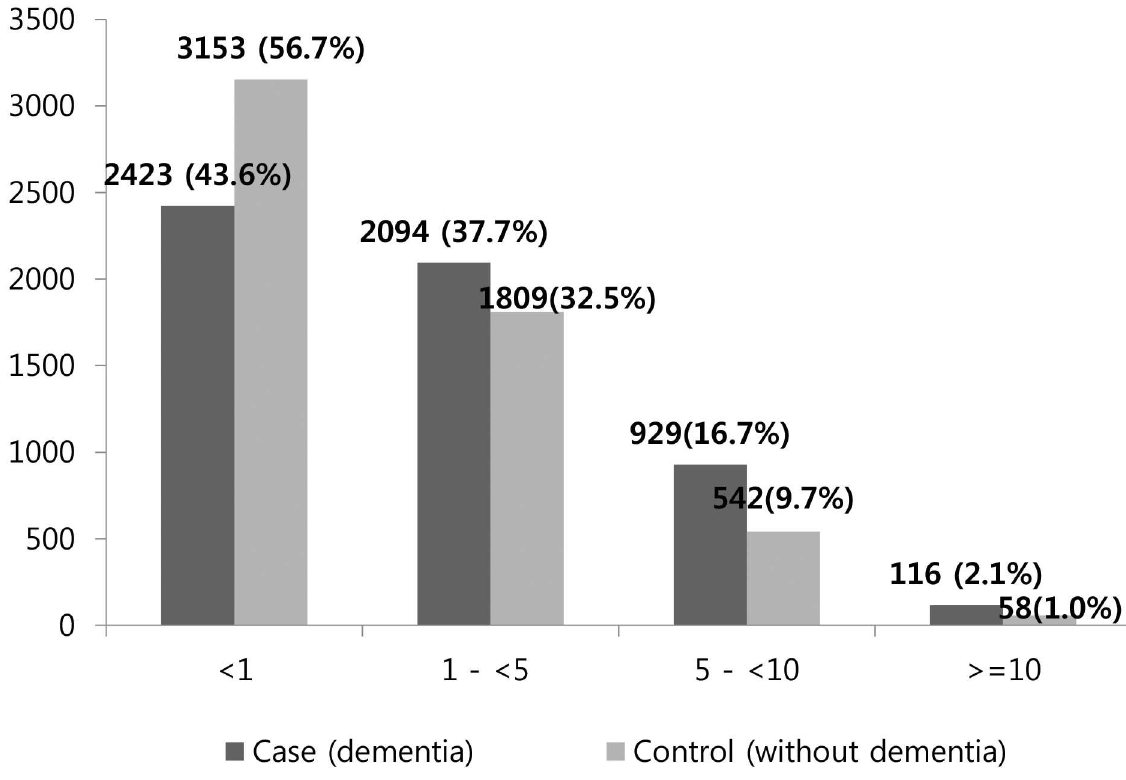
Fig 2. Prevalence of polypharmacy in cases and